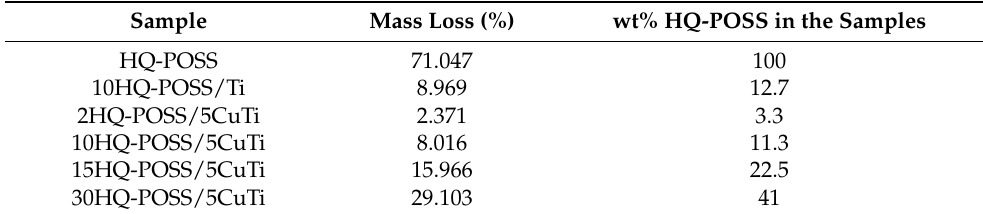
Figure 4. Thermogravimetric analysis of samples of HQ-POSS and materials (see Table 4). Table 4. Real composition of samples as determined by TGA.